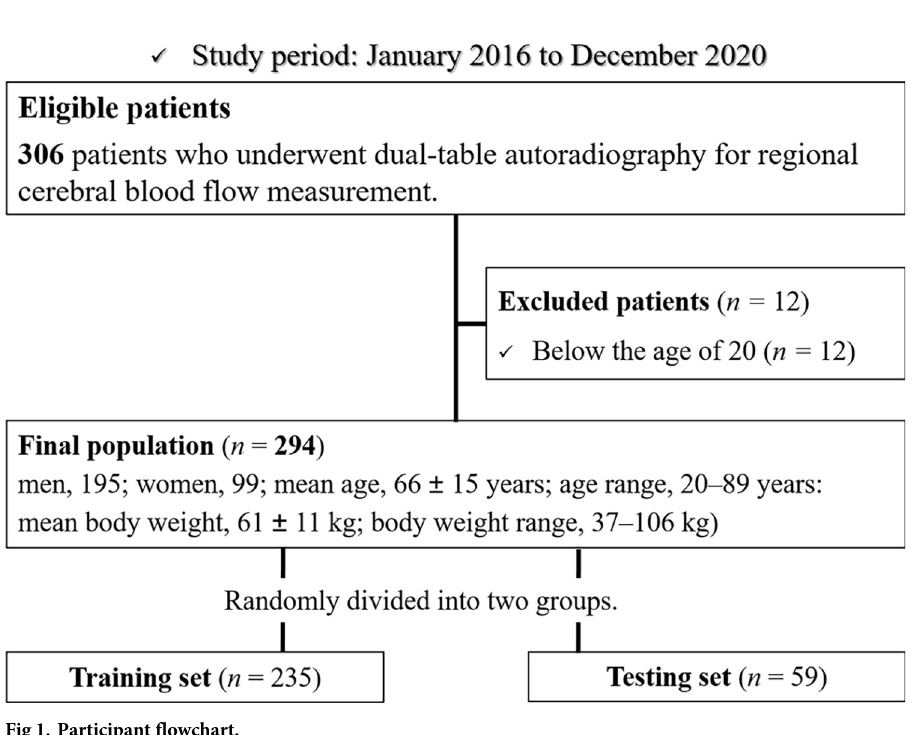
Fig 1. Participant